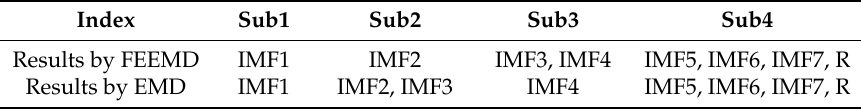
Table A4. The new subsequences after being processed by FEEMD and EMD for the prediction of the Hubei carbon price.